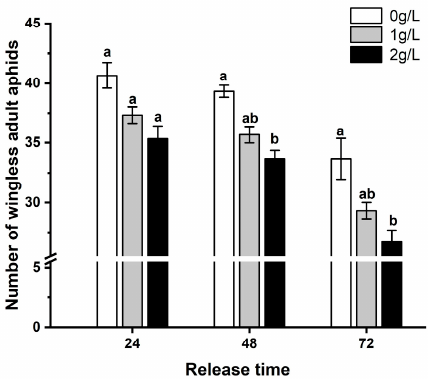
Figure 2. The number of S. avenae on isolated wheat leaves treated with different silicon concentra- tions. Bars with different letters are significantly different (Tukey’s HSD test, p = 0.01).